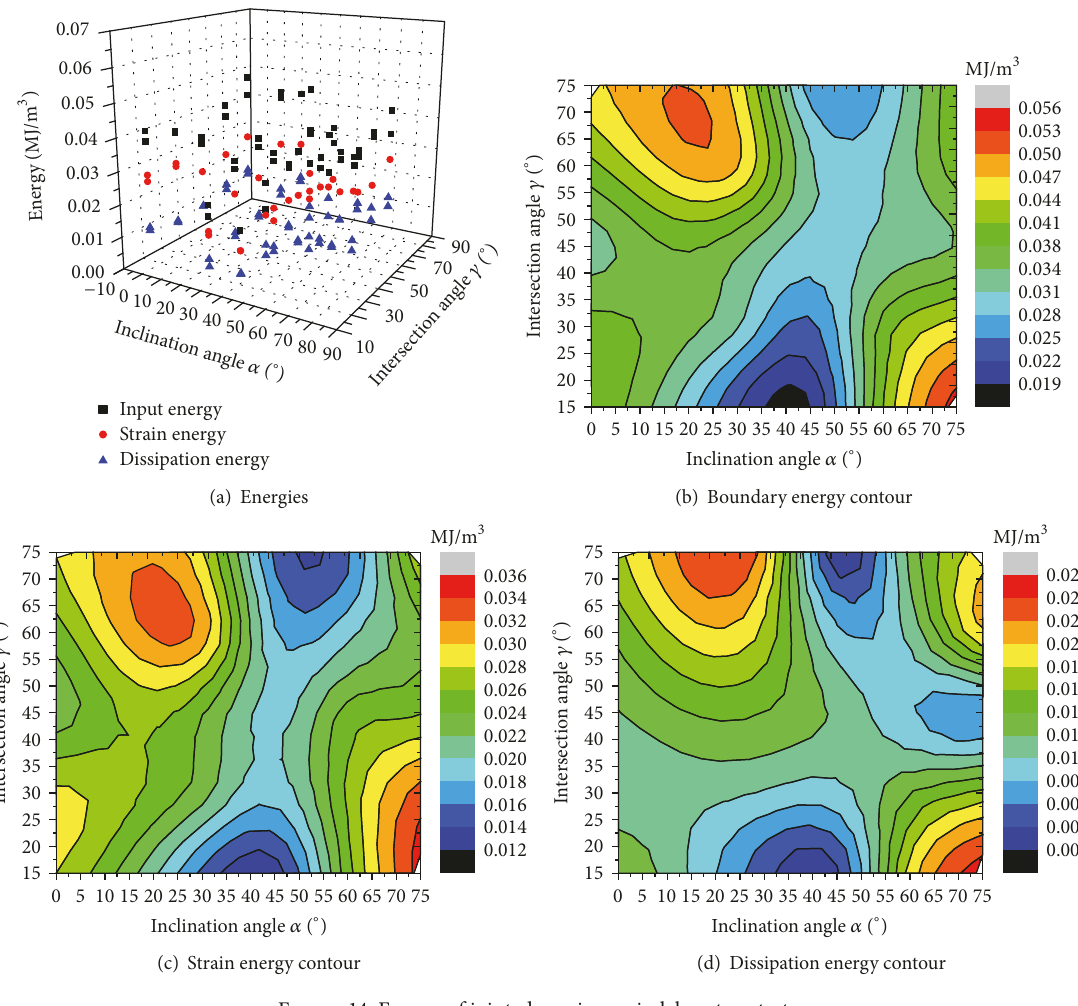
Figure 14: Energy of jointed specimens in laboratory tests.